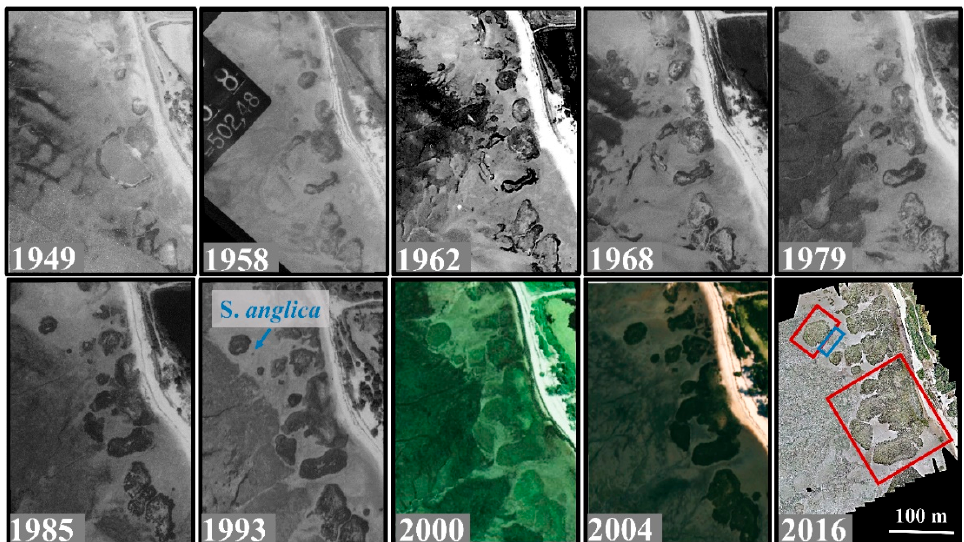
Figure 7. Salt marsh evolution at the study site of Andernos between 1949 and 2016. Dates up to 2004 correspond to airborne aerial photographs, and the image from 2016 was acquired by drone. Two zones of Spartina maritima dominance are indicated by red boxes, and Spartina anglica dominance patches are indicated by the blue box in the drone image. The bigger red box corresponds to the patch considered in the text as the main marsh structure. The appearance of the invasive Spartina is indicated in the 1993 image by the blue arrow.